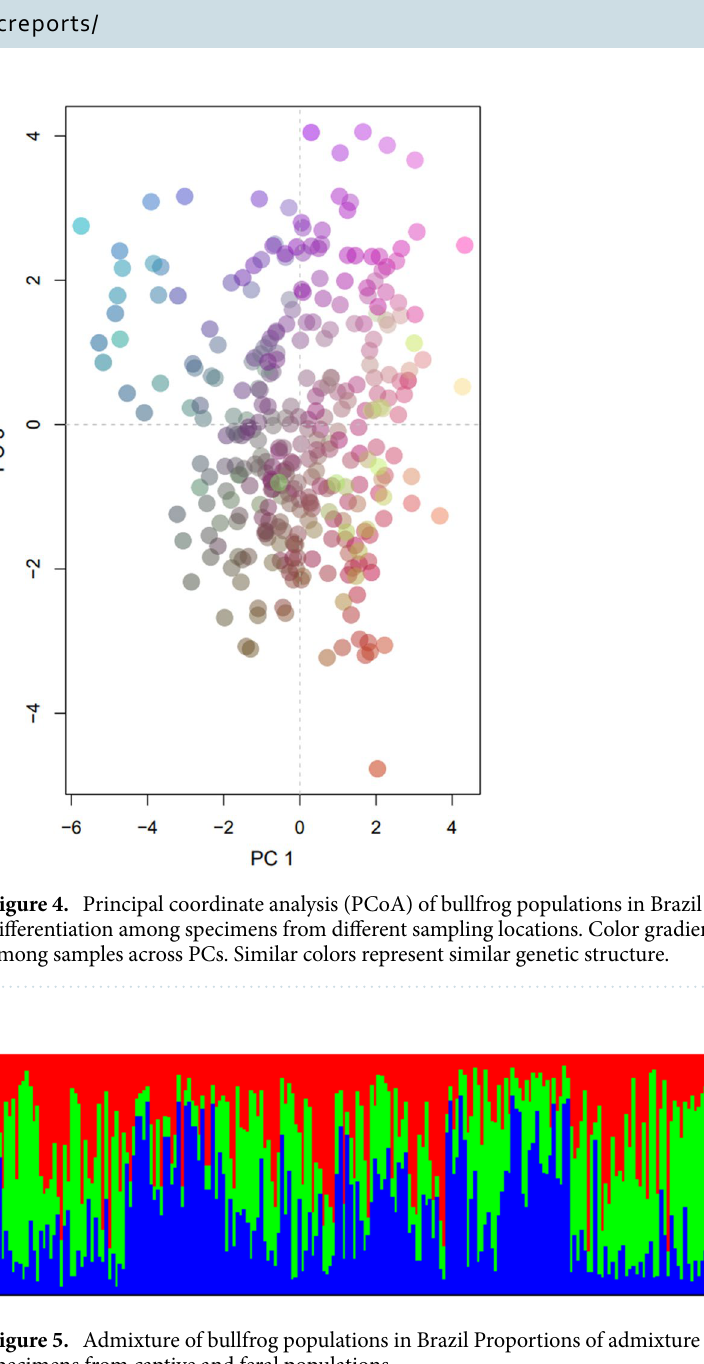
Figure 5. Admixture of bullfrog populations in Brazil Proportions of admixture (K = 3) among bullfrog specimens from captive and feral